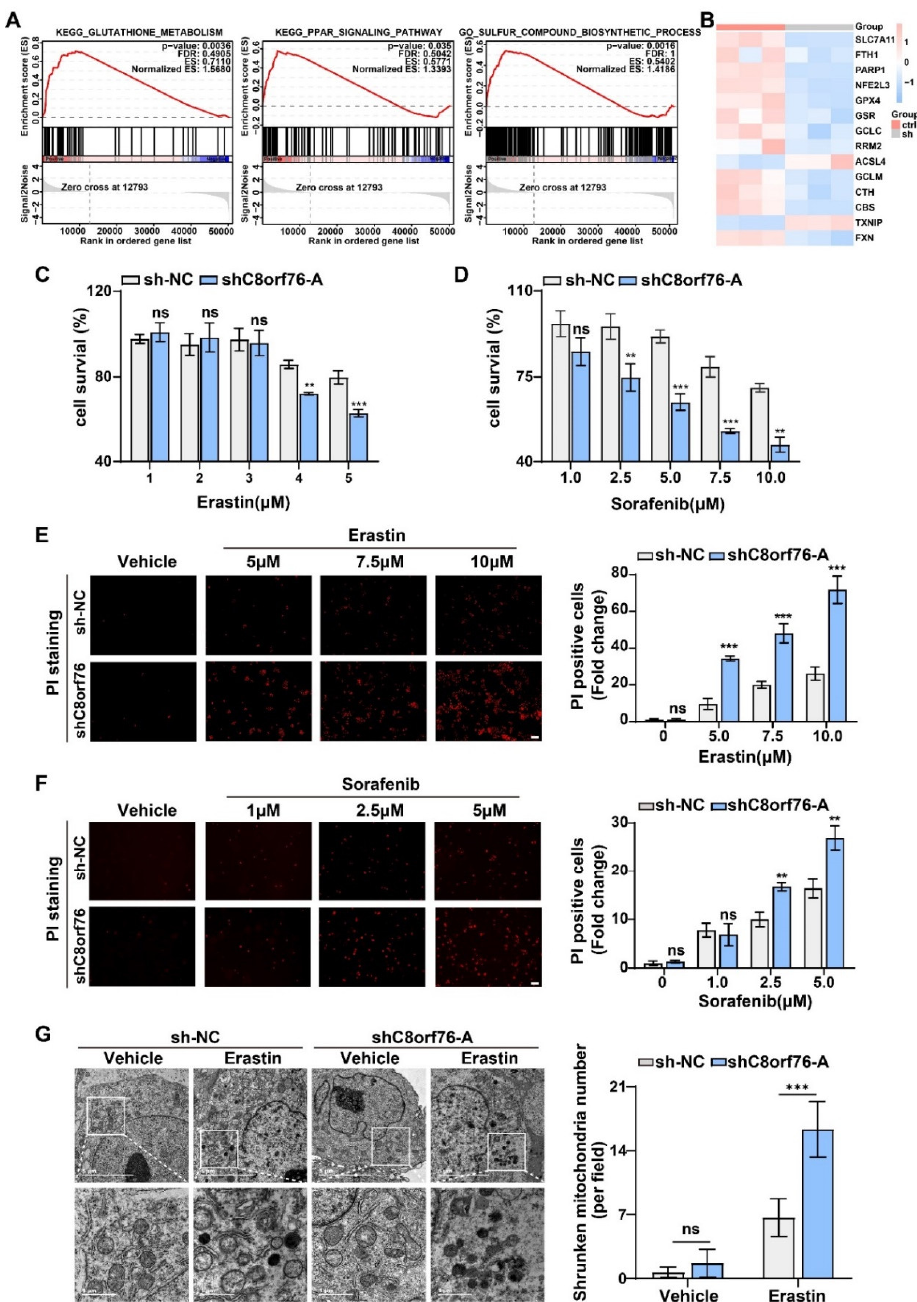
Figure 3. C8orf76 knockdown renders HCC cells susceptible for erastin and sorafenib. ( A ) Gene set enrichment analysis related to C8orf76 functions. ( B ) The heatmap of altered ferroptosis-associated genes. ( C , D ) JHH7 cells were exposed to different doses of erastin or sorafenib for 24 h and detected by MTS reagent. ( E , F ) The degree of the cell-membrane injury induced by erastin or sorafenib for 24 h was stained by propidium iodide and viewed under inverted fluorescent microscope. Scale bars represent 100 µ m. ( G ) Transmission electron microscopy images of mitochondria in C8orf76-depleted JHH7 cell line. Data were presented as mean +SD. ** p < 0.01; *** p < 0.001; ns, not